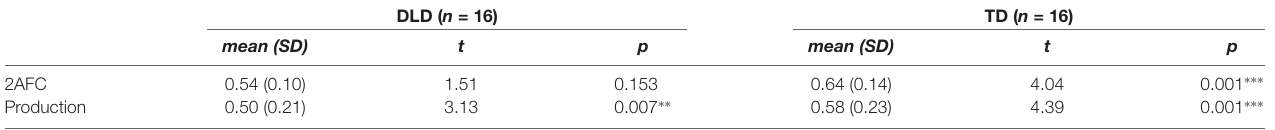
TABLE 6 | Descriptives and comparative statistics of groups performance relative to chance level in the offline visual non-verbal tasks.